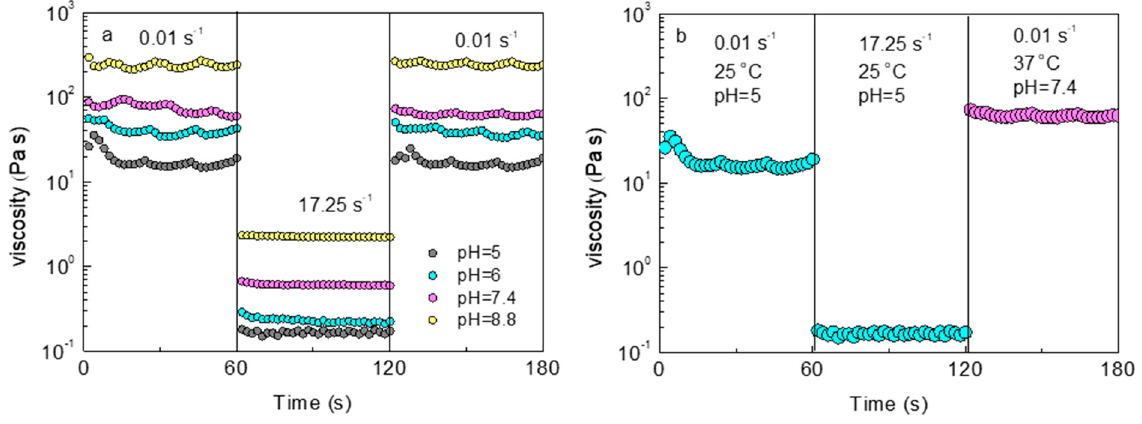
Figure 8. ( a ) Consecutive shear viscosity time sweep in time intervals of 60 s for the 0.5 wt% formulation at various pHs, as indicated. ( b ) Shear viscosity versus time in time intervals of 60 s, for the same formulation simulating an injection procedure.